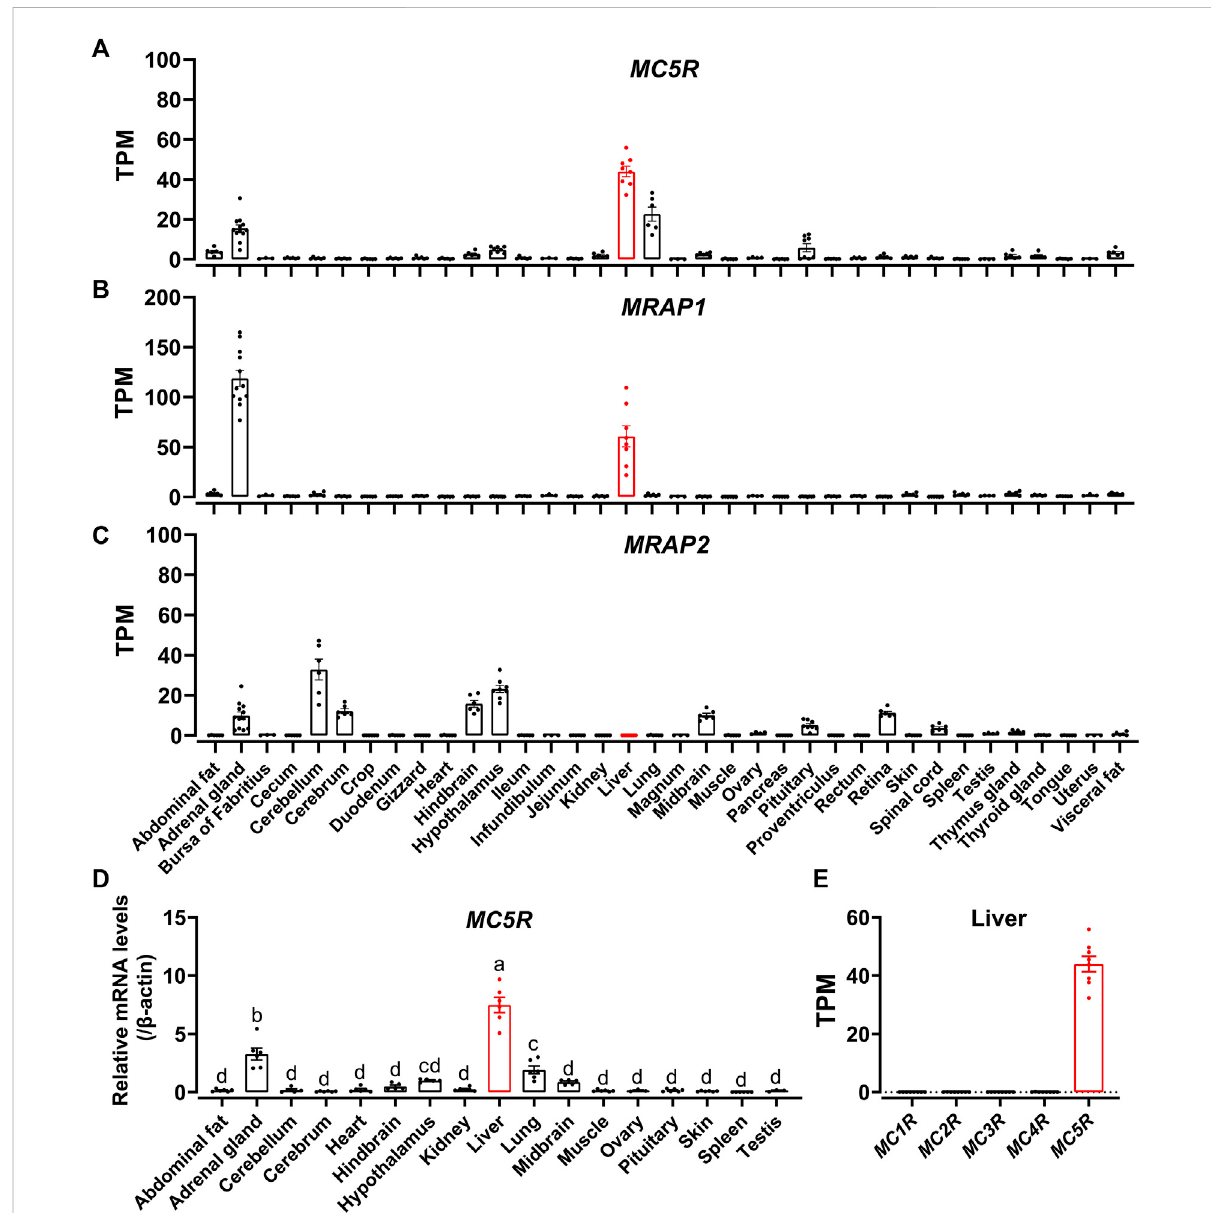
FIGURE 4 (A – C) RNA-seqdataanalysisshowedtheexpressionof MC5R (A) , MRAP1 (B) ,and MRAP2 (C) inadultLohmannLayerstrainchickentissues.Each dotrepresentsanindividual.Thetranscriptspermillion(TPM)valueswereusedtoestimatetheabundanceofmRNAtranscripts. (D) Quantitativereal- time PCR assay of MC5R mRNA levels in Lohmann Layer strain chicken tissues, including the cerebellum, midbrain, cerebrum, hindbrain, hypothalamus,anteriorpituitary,kidney,liver,lung,muscle,skin,testis,abdominalfat,heart,spleen,andovary.ThemRNAlevelsoftargetgenes were normalized to that of β -actin and expressed as the fold difference compared with that of the midbrain. Each data point represents the mean ± SEMofsixadultchickens( N =6,threemalesandthreefemales,one-year-old),exceptforthatofovaryandtestis,whichrepresentthemean±SEMof three adult chickens ( N = 3). Different superscripts (A – D) among the different developmental stages are signi fi cantly different ( p < 0.05) by one-way ANOVA test, followed by Dunn ’ s multiple comparison test. (E) The mRNA expression of fi ve MCRs in the Lohmann Layer liver tissue using transcriptome data from our gene expression atlas (https://chickenatlas.avianscu.com/). The transcripts per million (TPM) values were used to estimate the abundance of mRNA